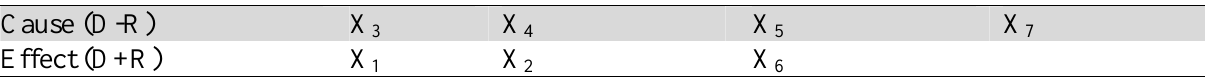
Causal and effect factors